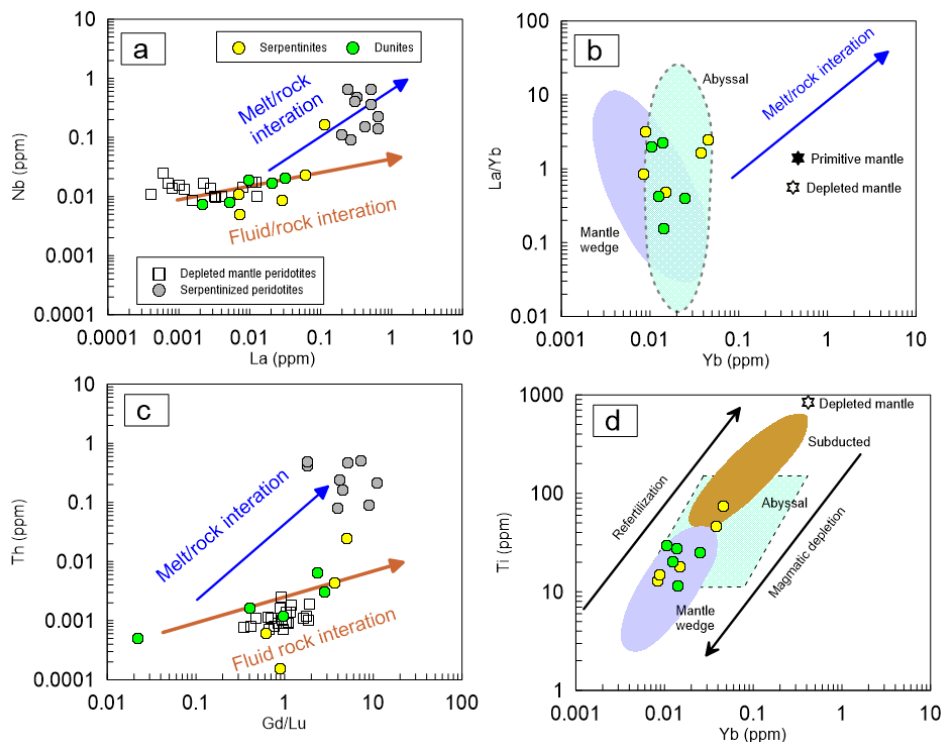
Figure 12. Binary plots of ( a ) La vs. Nb; ( b ) Yb vs. La/Yb; ( c ) Gd/Lu vs. Th; ( d ) Yb vs. Ti for the studied peridotites. The melt/rock interaction trends (blue lines) and the fluid/rock interaction trends (orange brown lines) in mantle peridotites are from Deschamps et al. [56]. Data of depleted mantle peridotites [59] and serpentinized peridotites [52] are shown for comparison. The fields of abyssal peridotites (turquoise green) are from Niu [50]. Compositional fields of mantle wedge (powder blue) and subducted serpentinites [56] are shown for comparison. Estimated compositions of the depleted mantle [109] and of the primitive mantle [90] are also presented for